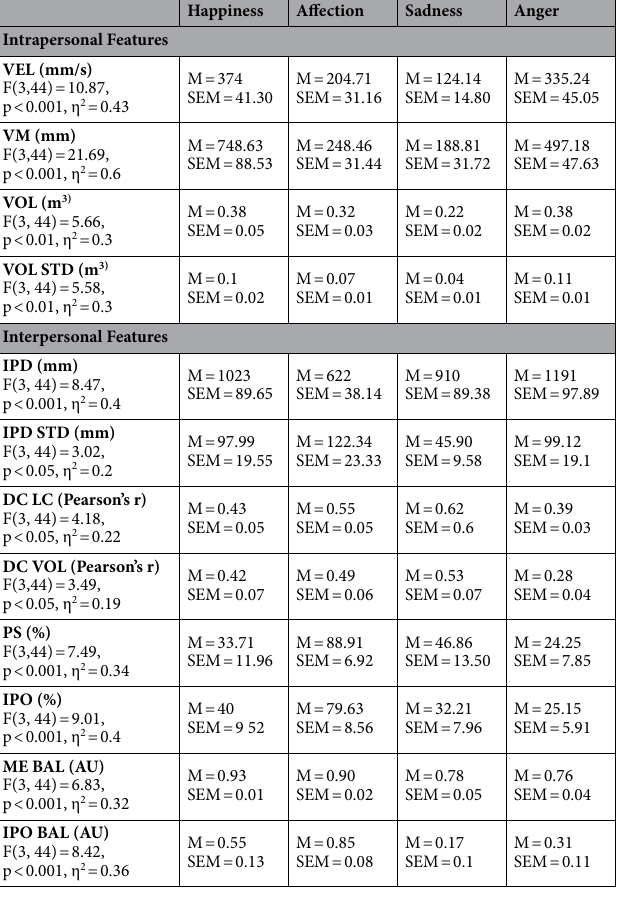
Table 2. ANOVA of feature emotion